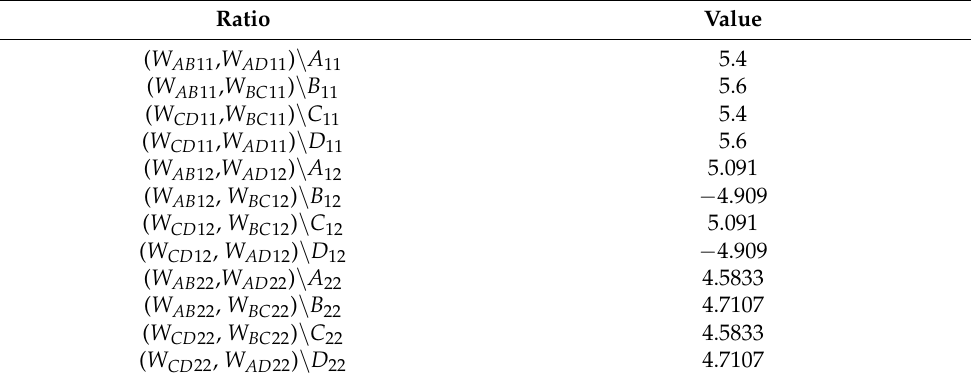
Table 7. The division coefficients defining selected B vij